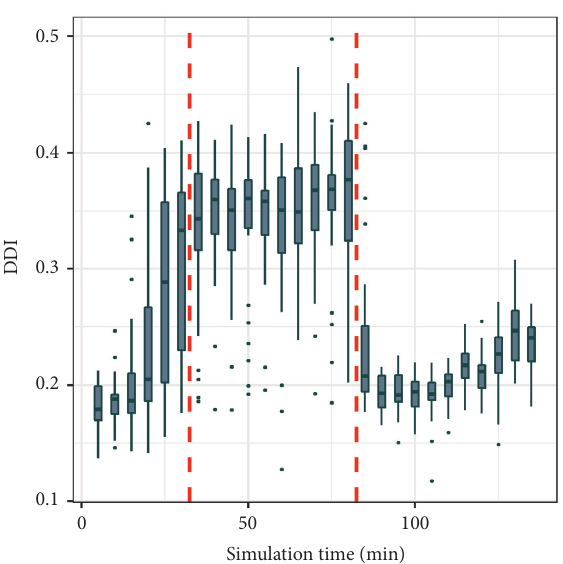
Figure 5: Boxplots of DDI values of 30 different simulations at every sampling interval.